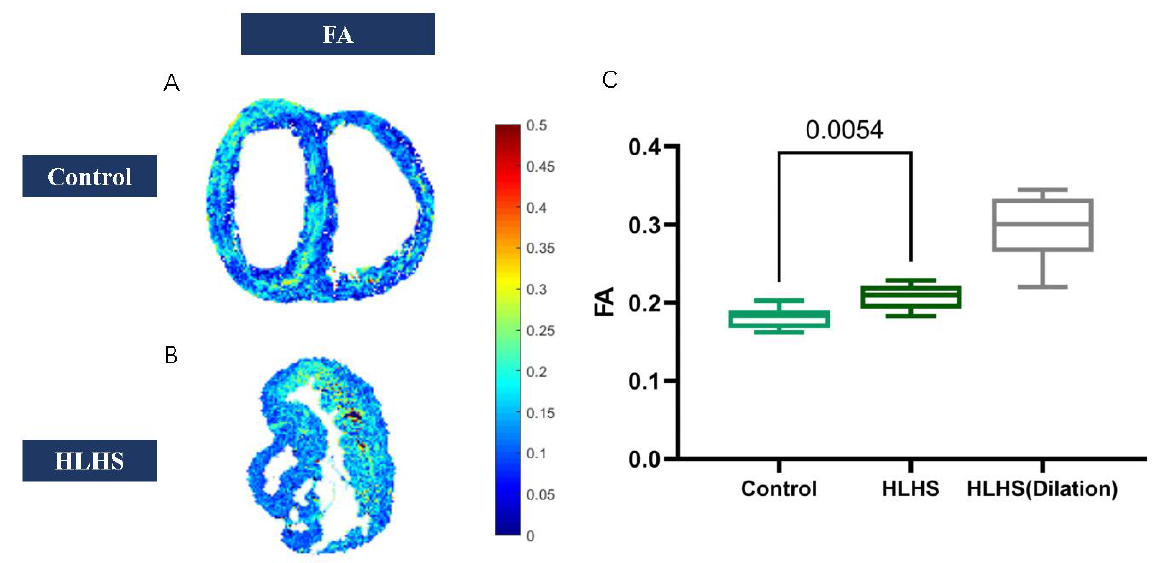
Figure 2. ( A ) FA map in normal fetuses. ( B ) FA map in HLHS fetuses. ( C ) FA values increased in HLHS fetuses. Table 6. Right ventricular myocardial microstructure dynamics in HLHS and control specimens at 24~30 gestational